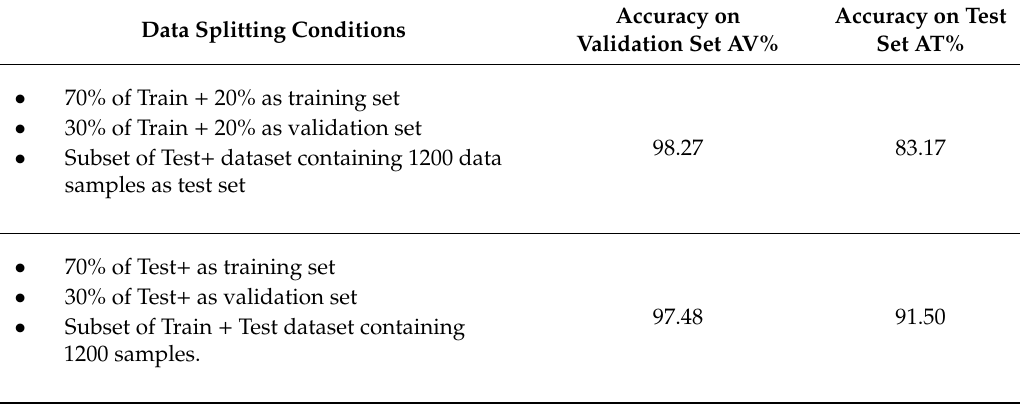
Table 7. Accuracy rate of intrusion detection by using di ff erent data splitting conditions.